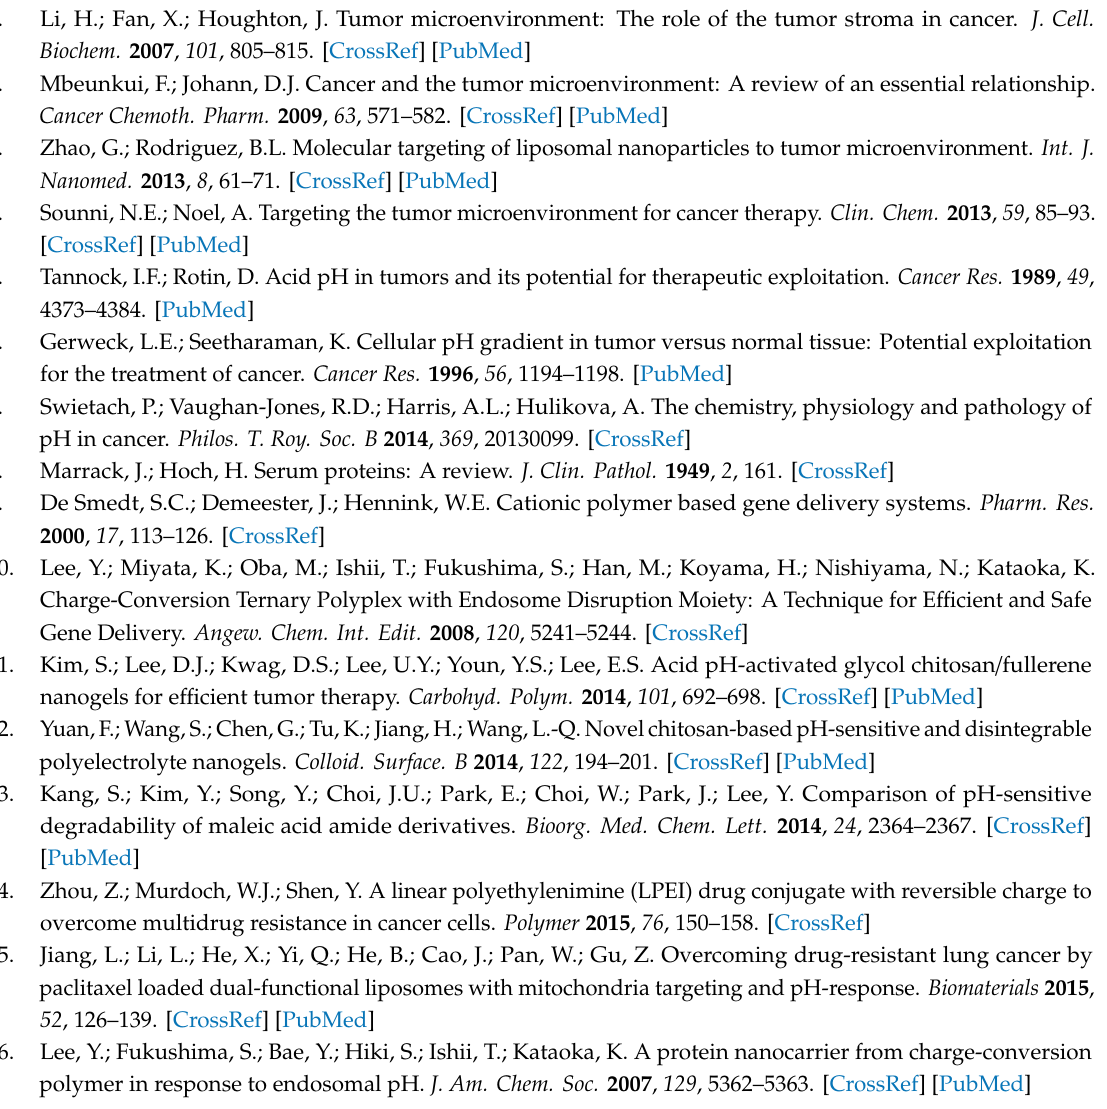
Figure S1. Size distribution histograms of PK 5 E 7 (PEI-rGO) nanostructures, Figure S2. Z-average sizes of PEI-rGO and PK 5 E 7 (PEI-rGO) at pH 7.4 and pH 6.0 in PBS bu ff er, Figure S3. Cellular uptake analysis of PK 5 E 7 (PEI-rGO / DOX) by flow cytometry in HeLa and A549 cells, Figure S4. The scheme for the formation of PKE(PEI-rGO / DOX) nanostructures and their serum stability and decorated serum protein-mediated cellular uptake by PKE